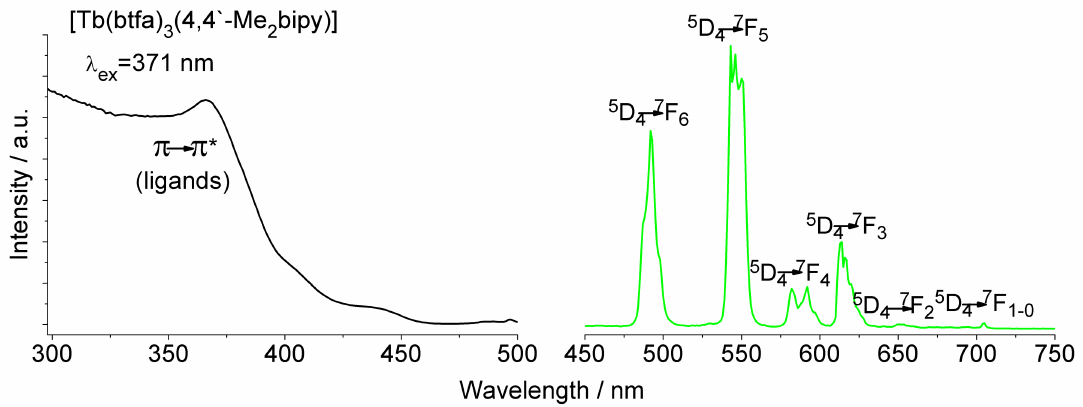
Figure 4. Excitation ( left ) and emission ( right ) spectra of compound 9